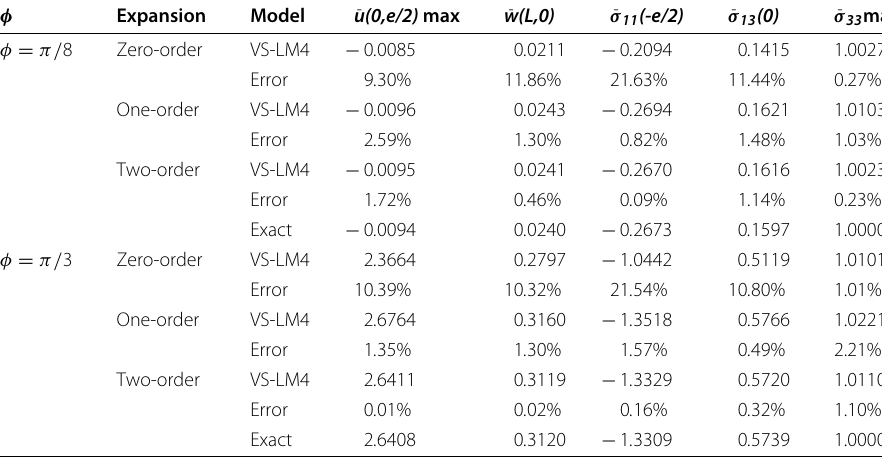
Table 5 Influence of the order-approximation of 1 /μ —one layer [0 ◦ ] - S = 4 —mesh 26 × 10—numerical layers N z = 4 ×